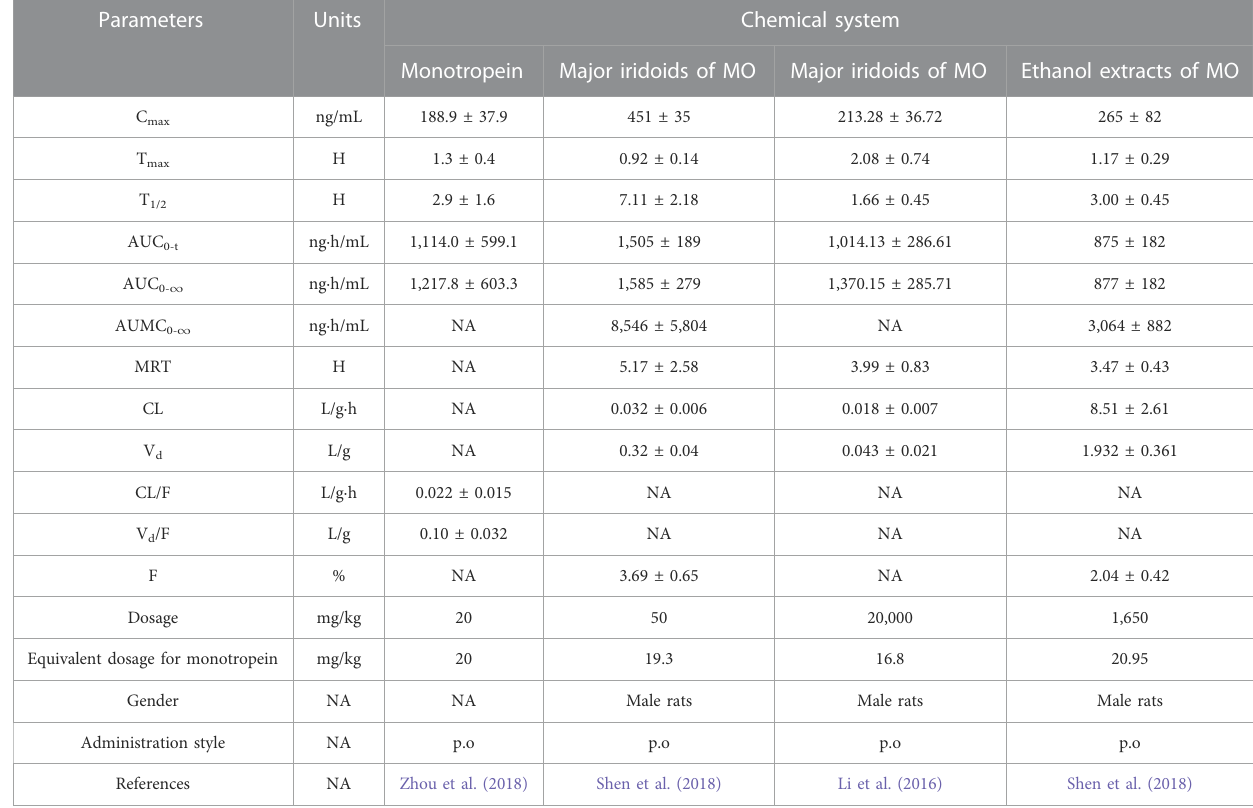
TABLE 2 Pharmacokinetic parameters of monotropein following oral